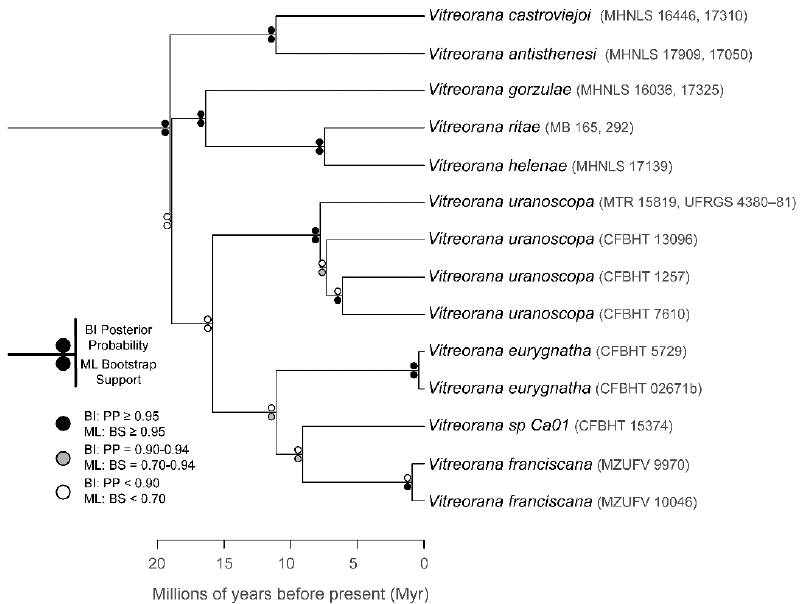
Figure 227. Evolutionary relationships of species in the glassfrog genus Vitreorana . The tree was inferred using maximum likelihood and Bayesian criteria.